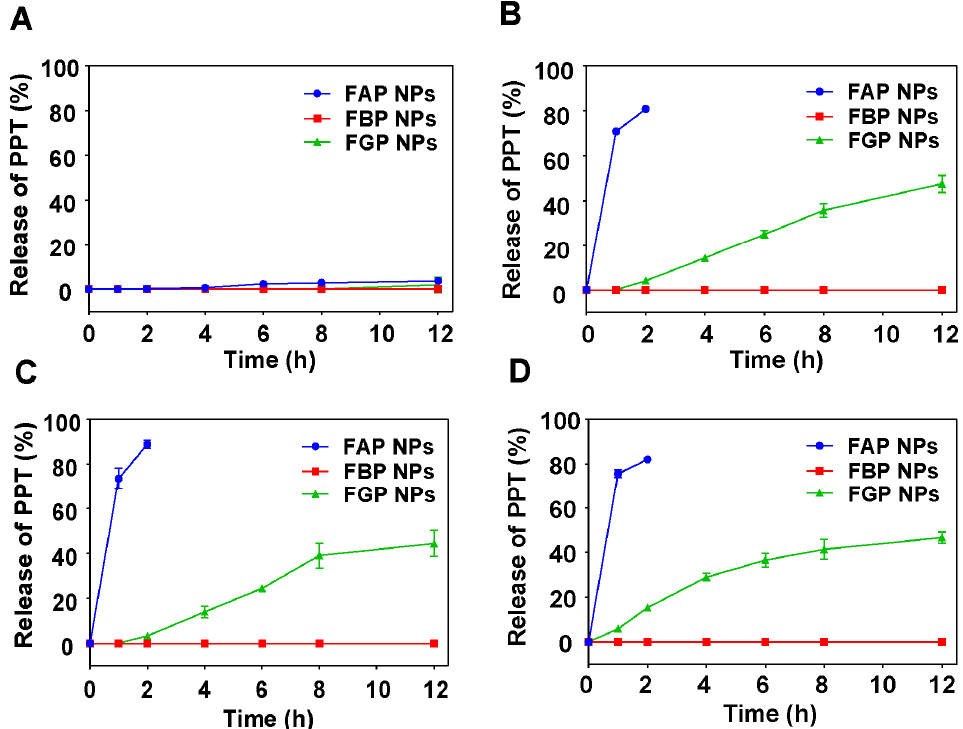
Figure 2. In vitro reduction-responsive drug release under the conditions of ( A ) 0 mM DTT, ( B ) 2 mM DTT, ( C ) 5 mM DTT and ( D ) 10 mM